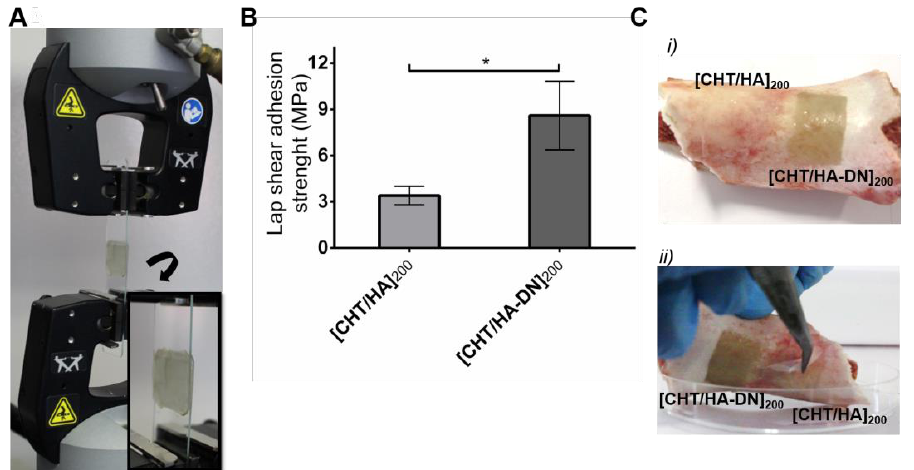
Figure 6. Adhesive properties of the freestanding membranes. ( A ) Mounting scheme for testing the lap shear adhesion strength on the Instron equipment; ( B ) lap shear adhesions strength values for each system. Significant differences were found for p < 0.05. ( C ) Representative images of the adhesiveness potential of [CHT/HA] 200 and [CHT/HA-DN] 200 freestanding membranes on a clean surface of porcine bone: (i) before and (ii) after applying a detachment force with tweezers.